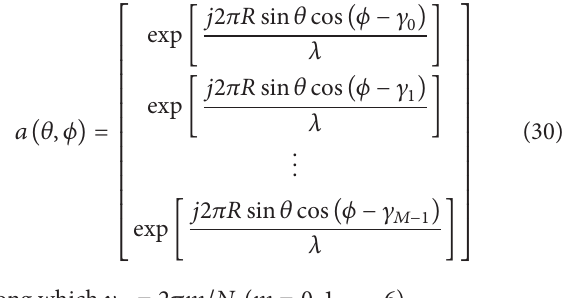
Figure 14: The array antenna pattern of the proposed method: the angles of arrival of the satellite signal are 10 degrees, − 25 degrees, and 40 degrees and the angles of arrival of jamming signals are − 14 degrees, − 22 degrees, − 60 degrees, and 24 degrees.